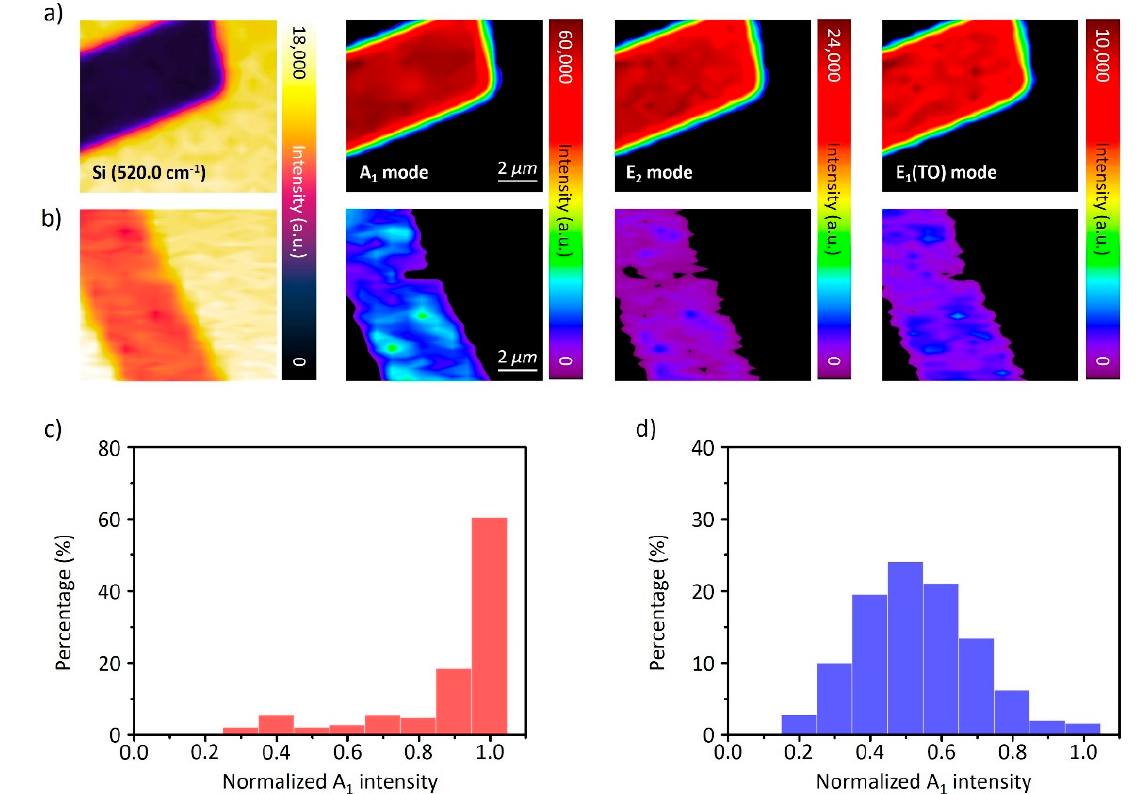
Figure 4. Raman intensity mapping images of A 1 , E 2 , and E 1 (TO) at the different thicknesses of 2D Tellurium. ( a ) 80 nm and ( b ) 50 nm; ( c ) Histogram of normalized A 1 mode intensity according to ( a ); ( d ) Histogram of normalized A 1 mode intensity according to ( b ).